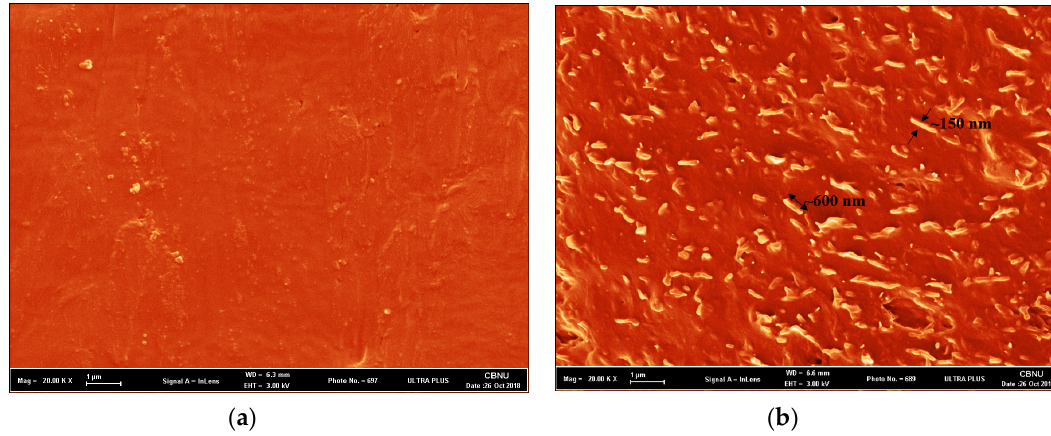
Figure 6. Representative field emission scanning electron microscope (FESEM) micrographs of ( a ) the PCL-PU and ( b ) the PCL-PU-Chitosan biocomposite (Scale bar: 1 µ m).